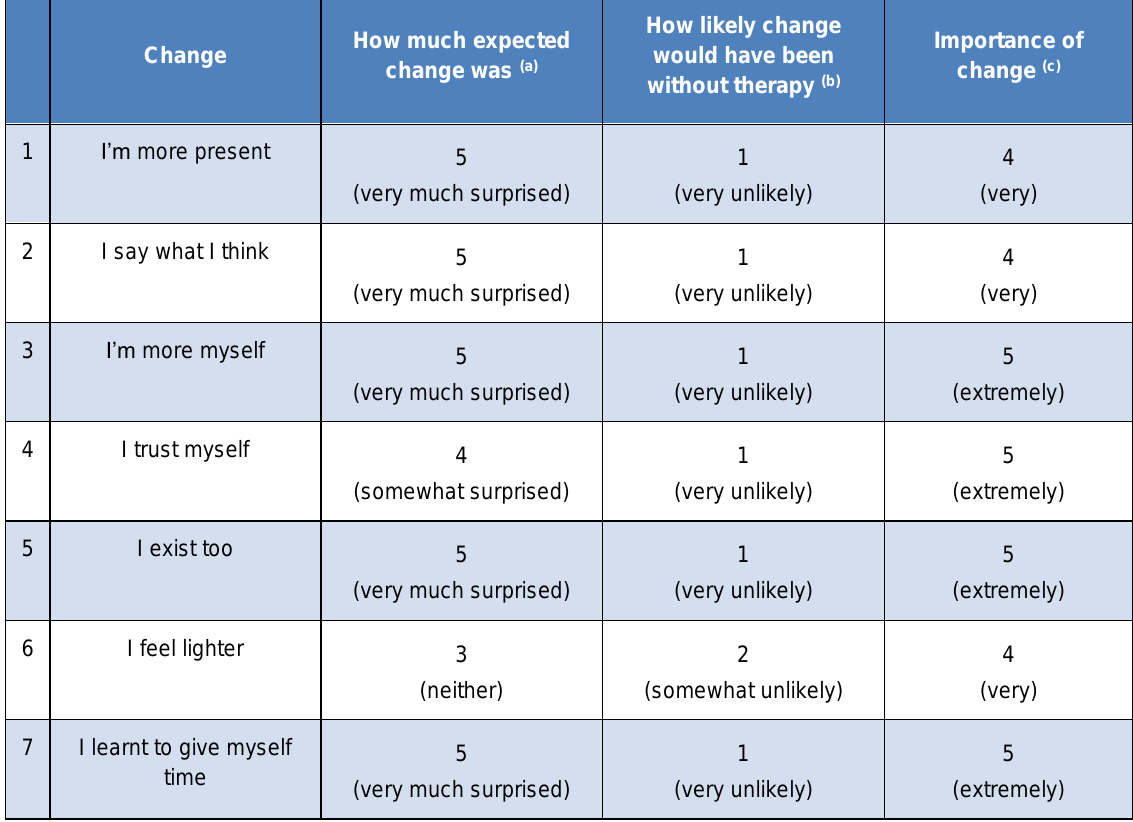
. Table 5: Margherita’s Changes identified in the Change